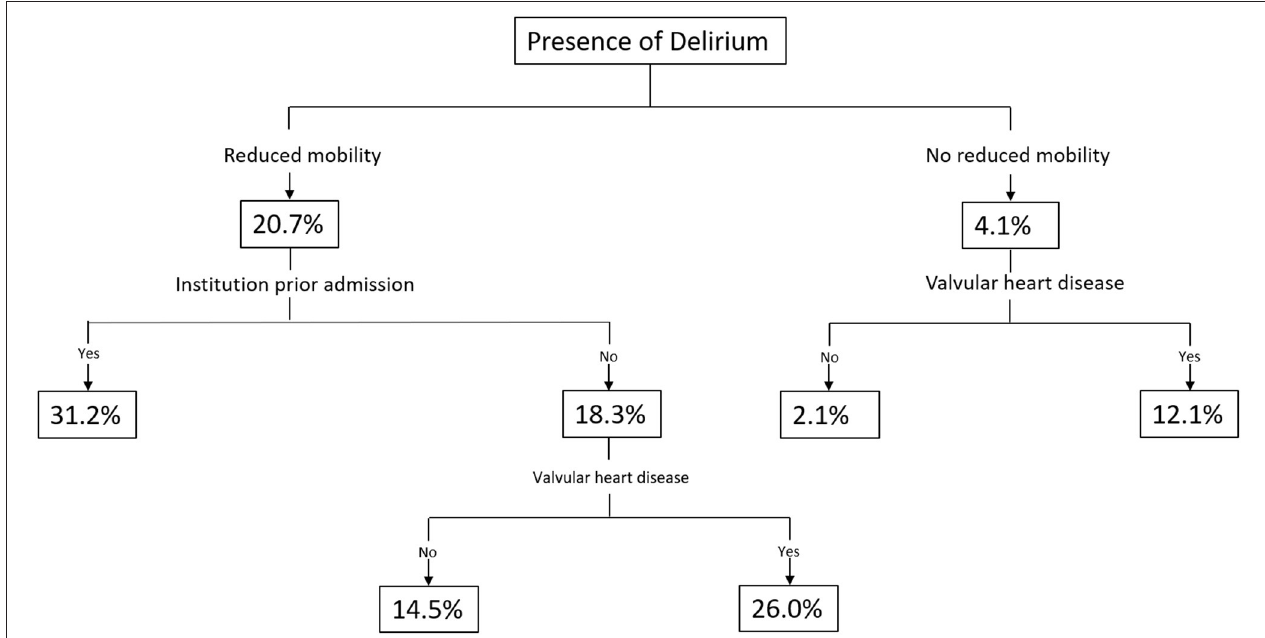
FIGURE 3 | Prediction tree for the presence of